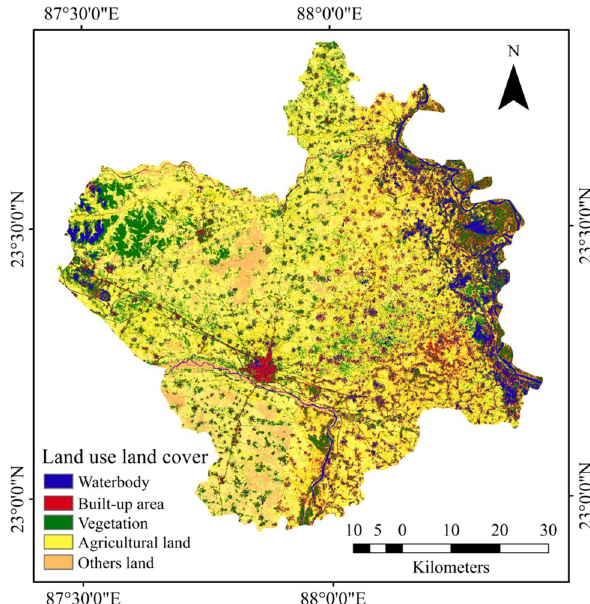
Fig. 6 Land use land cover